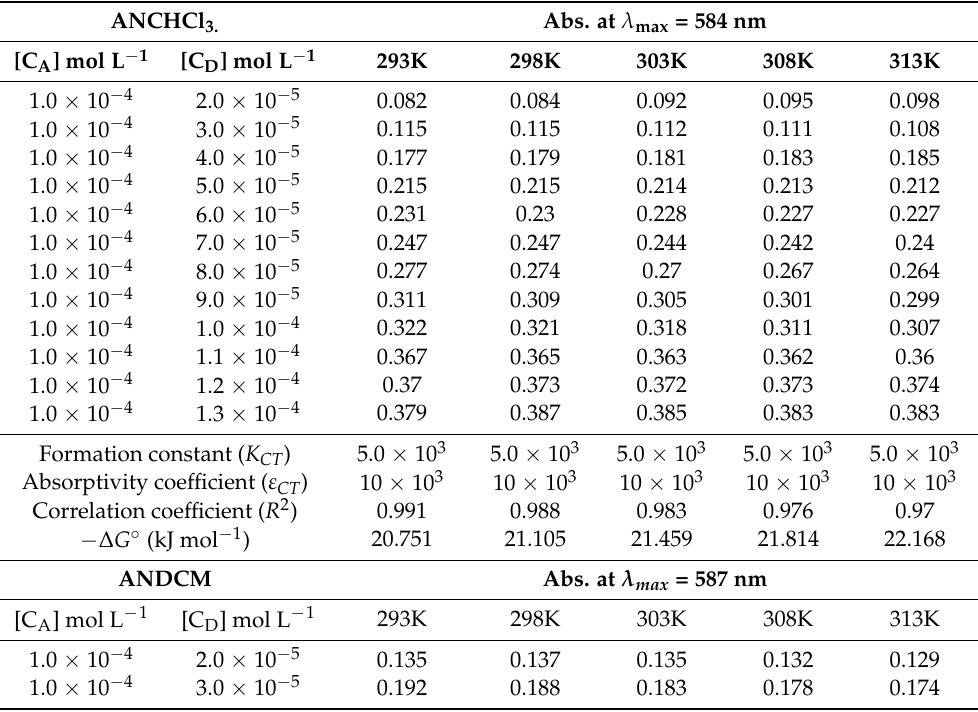
Table 1. Benesi–Hildebrand spectral data of AMFP–DDQ CT complex in different solvent systems. ANCHCl